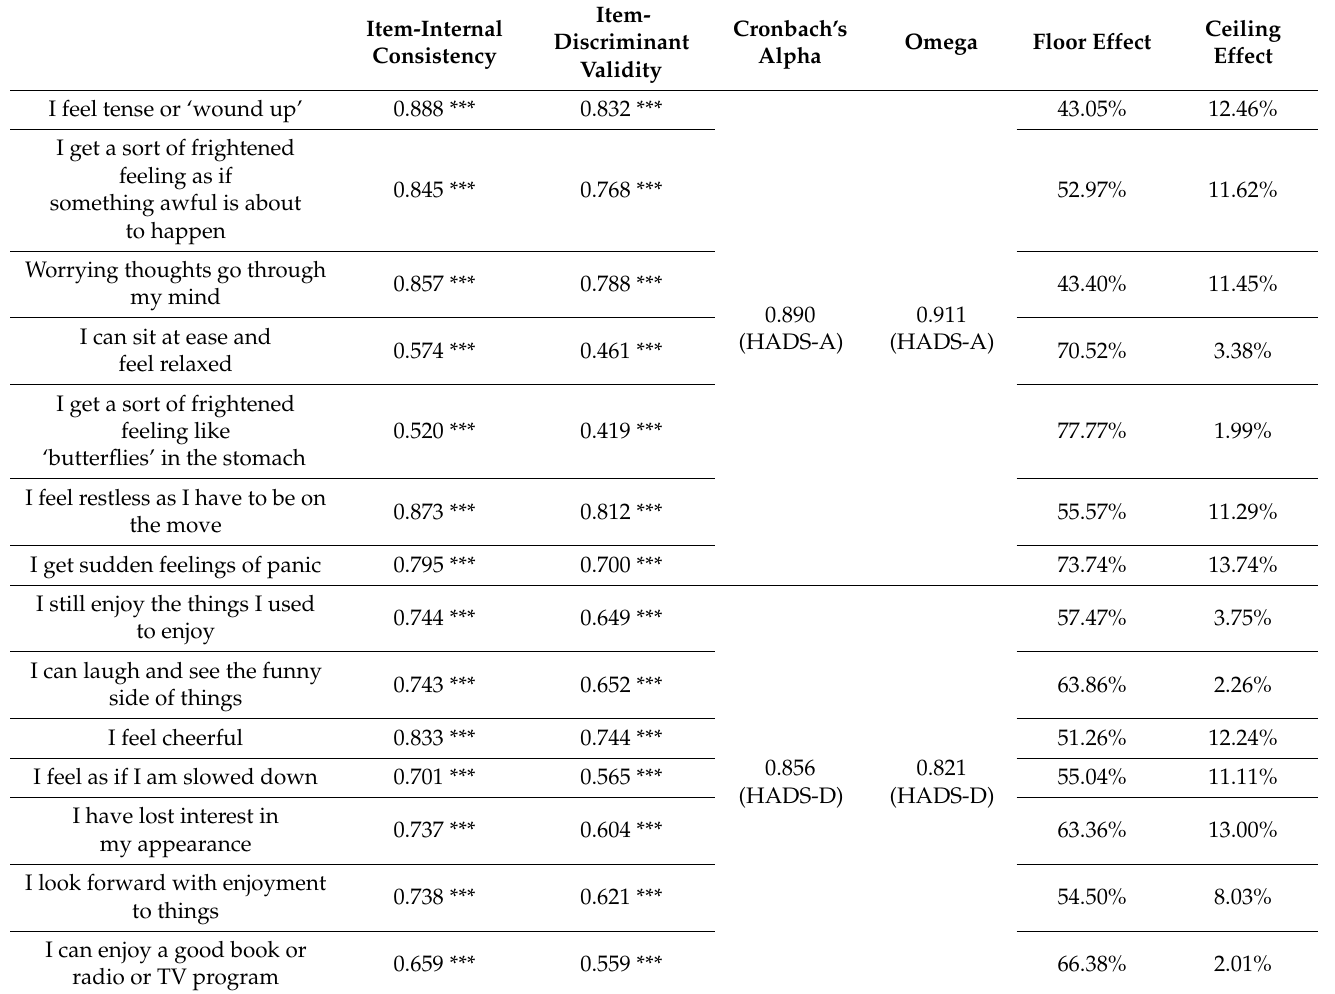
Table 2. Internal Consistency, Discriminant Validity, Floor and Ceiling Effect of each Item of the Hospital Anxiety and Depression Scale (HADS) in COVID-19 survivors experiencing long